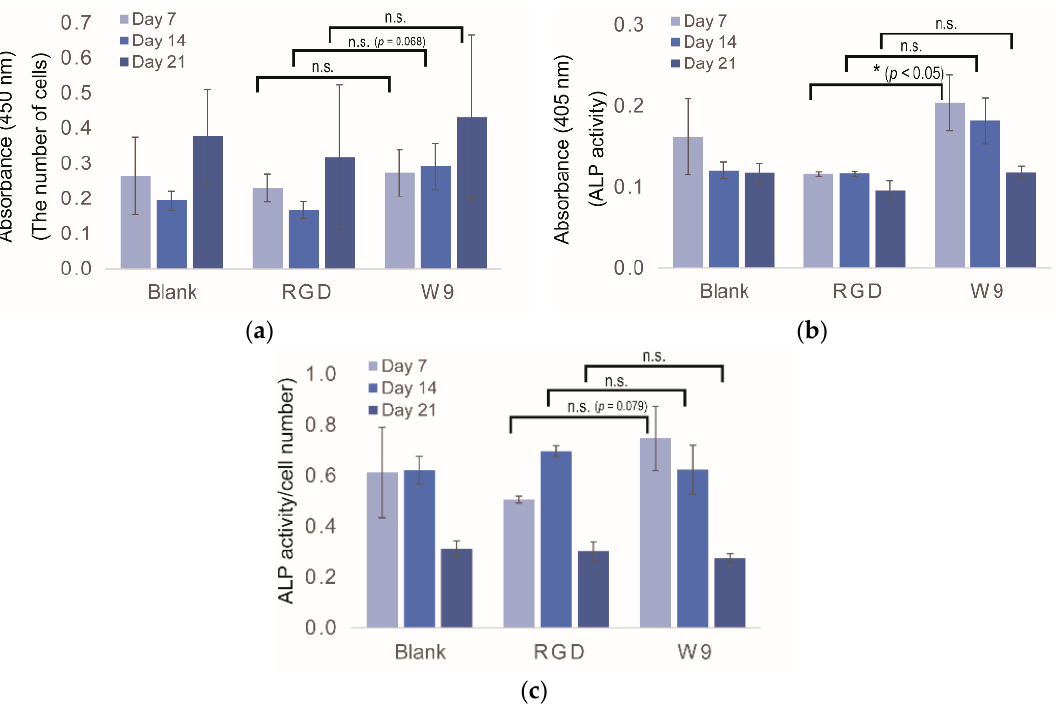
Figure 2. Conditions used for the peptide array screening. UC-MSCs were used for the experiment. ( a ) Proliferation assay by WST-8; ( b ) ALP activity assay; ( c ) ALP activity/cell number. Each assay was performed at Days 7, 14 and 21. Blank indicates no peptide. All experiments were performed in triplicate (* p < 0.05, n.s.: p ≥ 0.05).